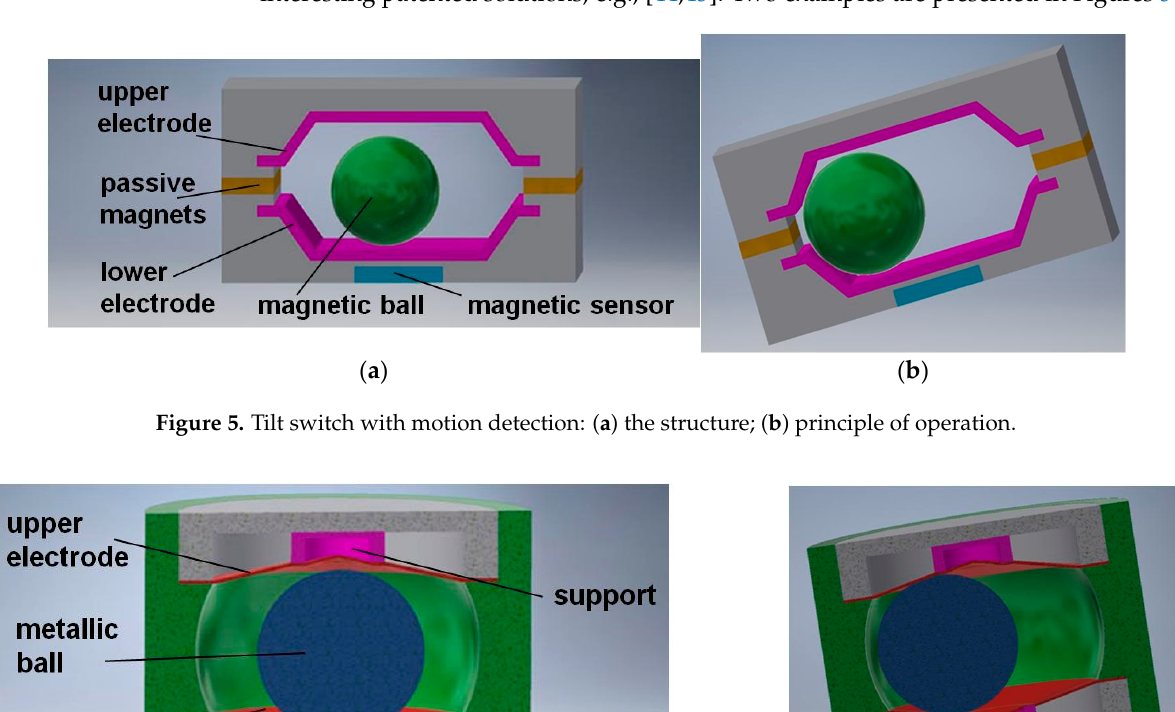
the side electrodes; ( d ) principle of operation.